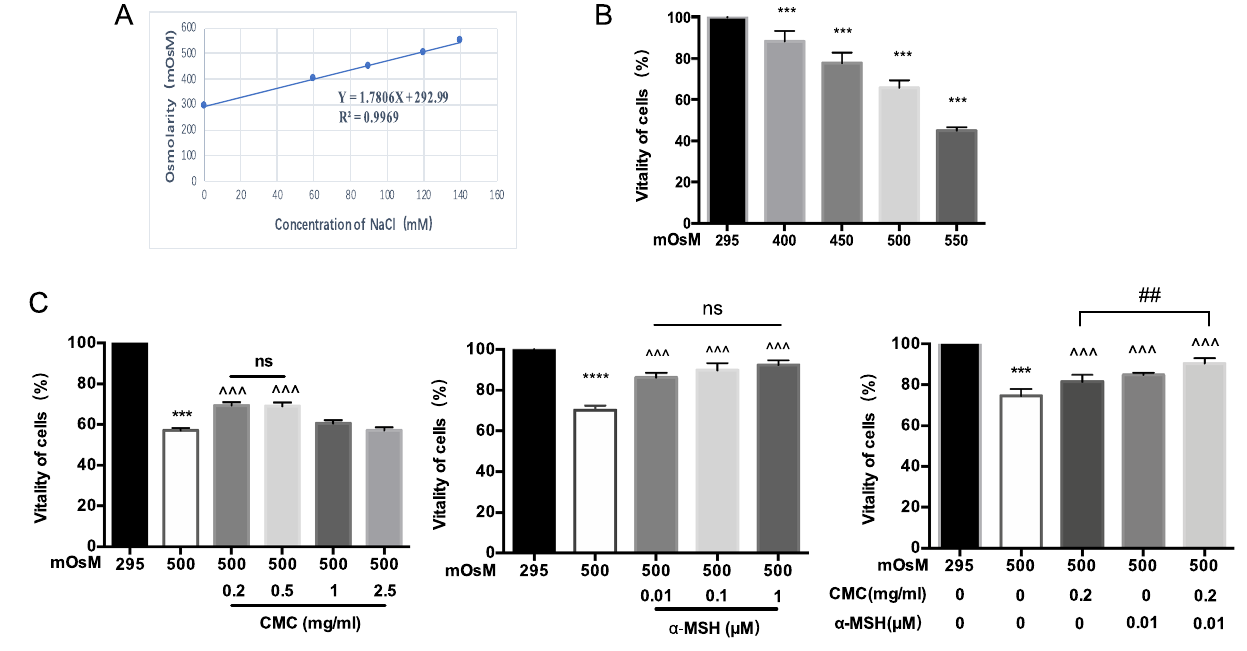
Figure 4. Combined CMC + α-MSH treatment enhanced the viability of HCECs exposed to hyperosmotic environmental stress. Linear relationship between concentrations of sodium dissolved in DMEM/F12 medium and corresponding osmotic pressure ( A ). Three samples were taken from different cell sites during osmotic pressure determination. HCEC viability was measured by CCK assay after treatment with several concentrations of sodium-containing medium, with and without CMC and α-MSH. Absorbance values represent relative cell viability (n = 6, B , C ). Three independent experiments were performed. Data are shown as mean ± SEM. *, comparison of hypertonic group and normal group; ^, comparison of CMC treatment group or α-MSH treatment group and hypertonic group; ns, not significant. *, ^ p < 0.05; **, ^^ p < 0.01; ***, ^^^ p < 0.001; ns, not significant.